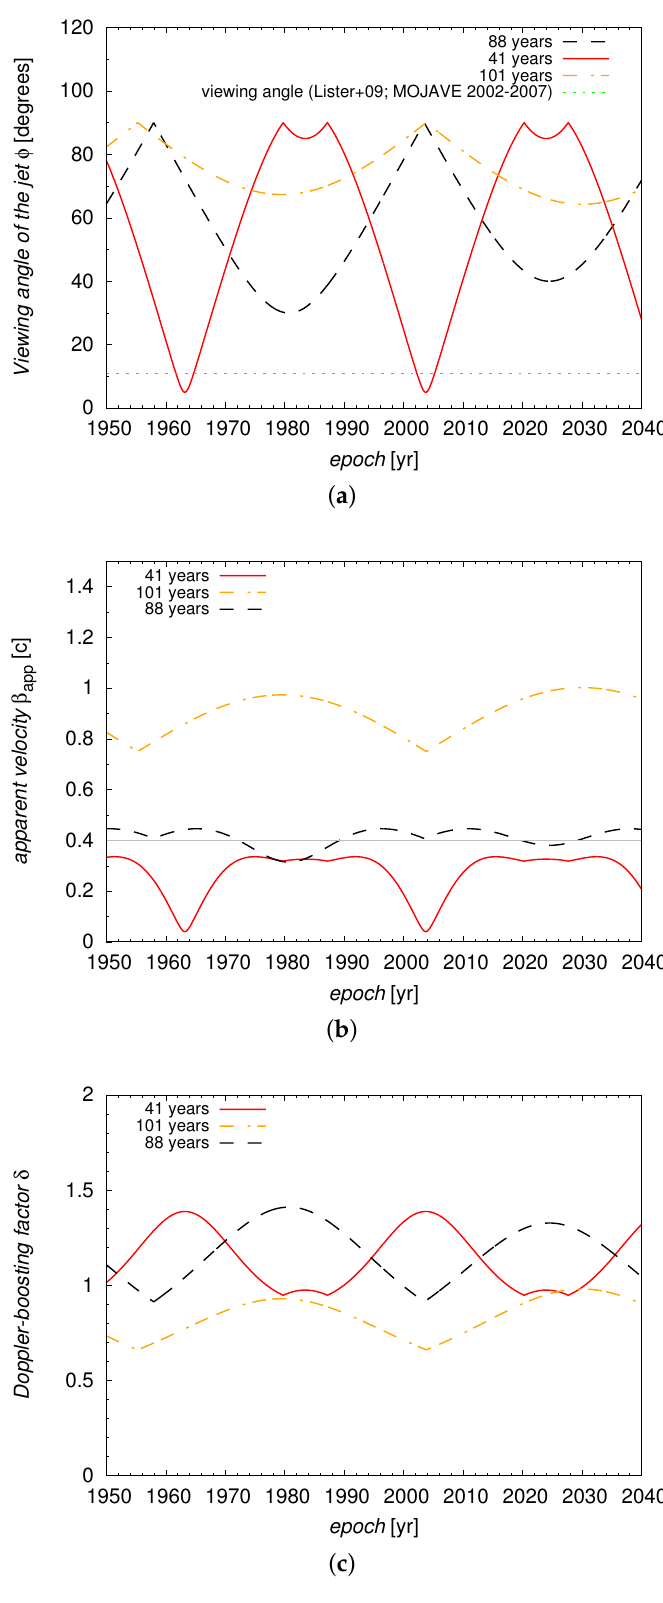
Figure 9. ( a ) Temporal evolution of the jet viewing angle φ ( t ) based on three precession models labelled according to different precession periods of 41, 88, and 101 years. The dotted horizontal line stands for the viewing angle inferred by Lister et al. [46] from the MOJAVE survey (2002–2007). ( b ) Temporal evolution of the apparent velocity which remains below 0.4c (for the precession model with 41 yr). ( c ) Temporal evolution of the Doppler factor which is less than 1.5 for all the precession